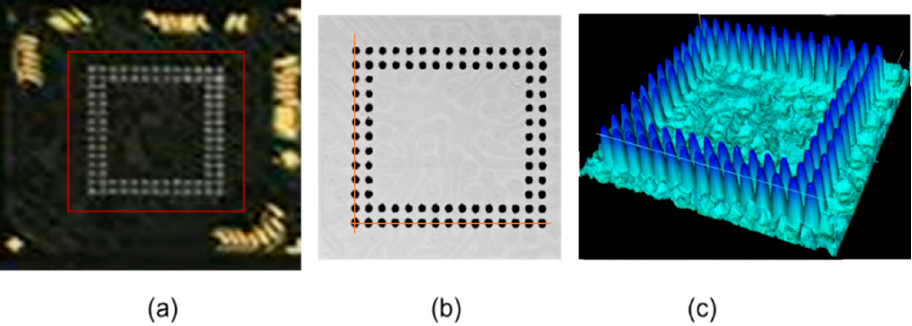
Figure 8. Reconstruction of the 3D BGA sample: ( a ) photograph of the scan area, ( b ) wrapped phase map, ( c ) 3D reconstructed topography.